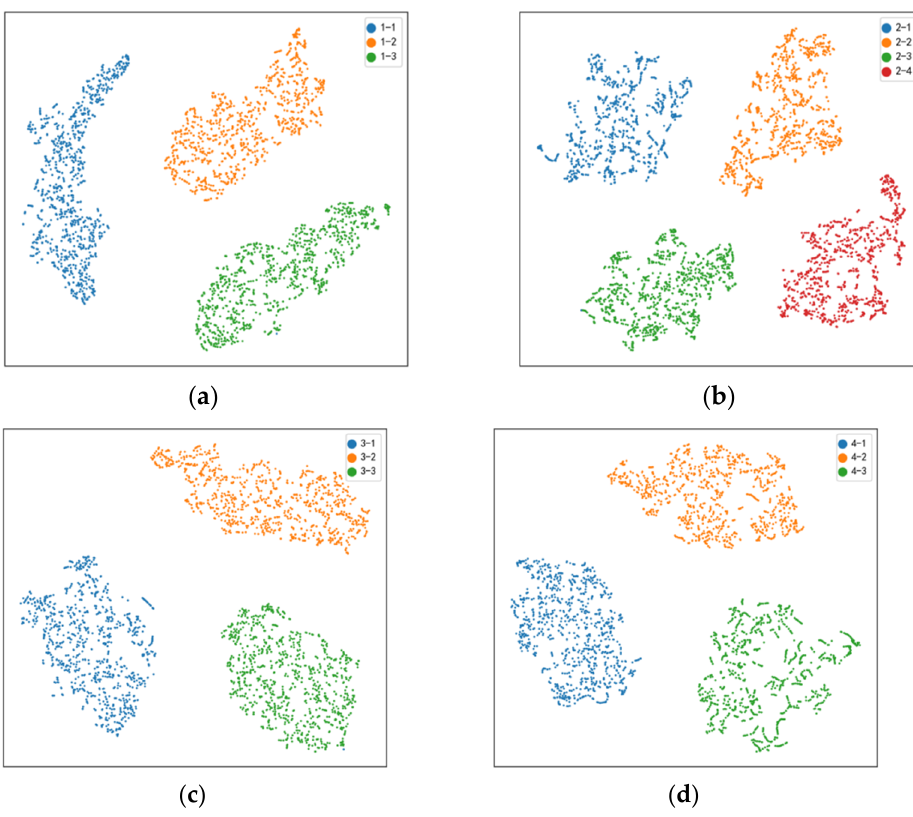
Figure 7. The t-SNE dimension reduction diagram of four faults (a-d: exhaust valve, cylinder, piston ring, and intake valve).